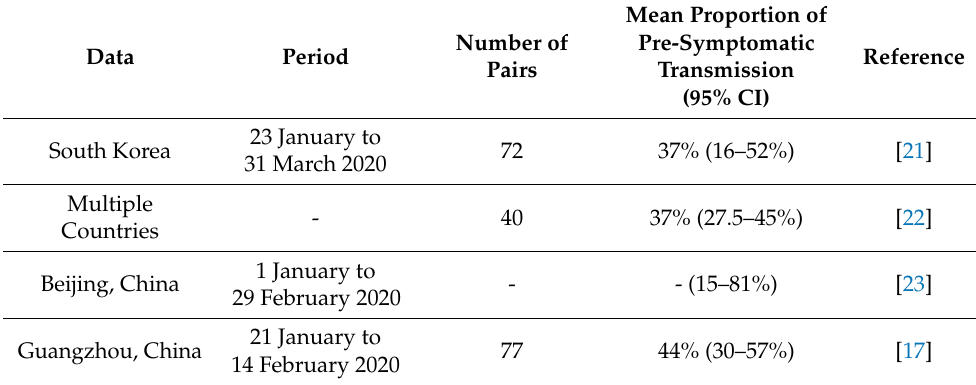
Table 2. Estimates of mean proportion of pre-symptomatic transmission.